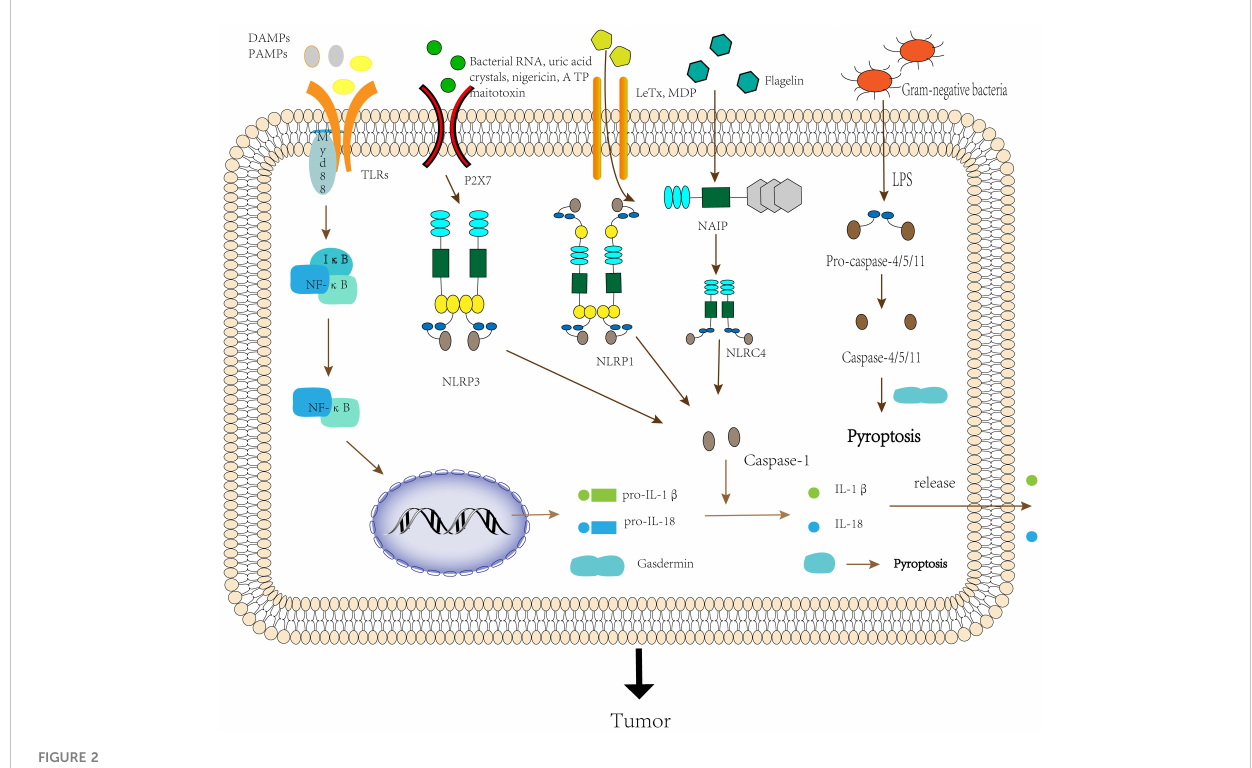
FIGURE 2 The activation process of the in fl